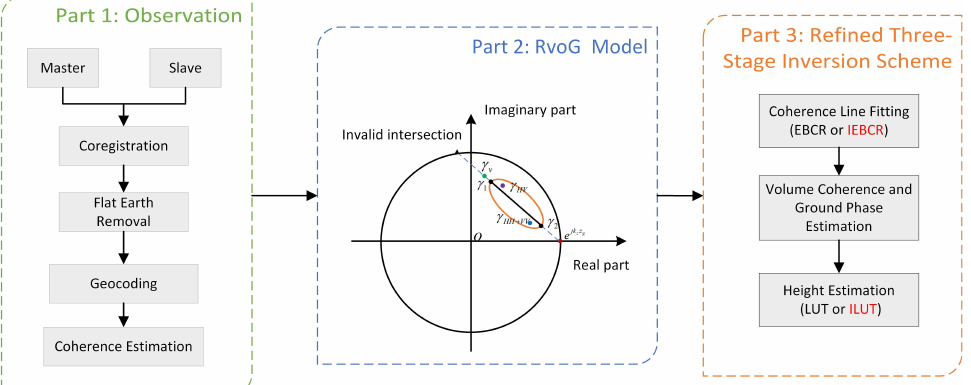
Figure 1. The PolInSAR flow. The figure in Part 2 depicts the geometrical interpretation of the RVoG model in the unit circle. The orange ellipse is the locus of BCR. The green, purple, blue, and red points are volume coherence, HV polarization coherence, HH+VV polarization coherence, and ground coherence, respectively. The black points denote two candidates of the volume coherence with the largest and smallest GVR, respectively. The blue dotted line linking γ v and e jk z z g is the theoretical distribution of coherence based on the RVoG model. The solid line over the blue dotted line is the visible segment. The black triangle is the invalid